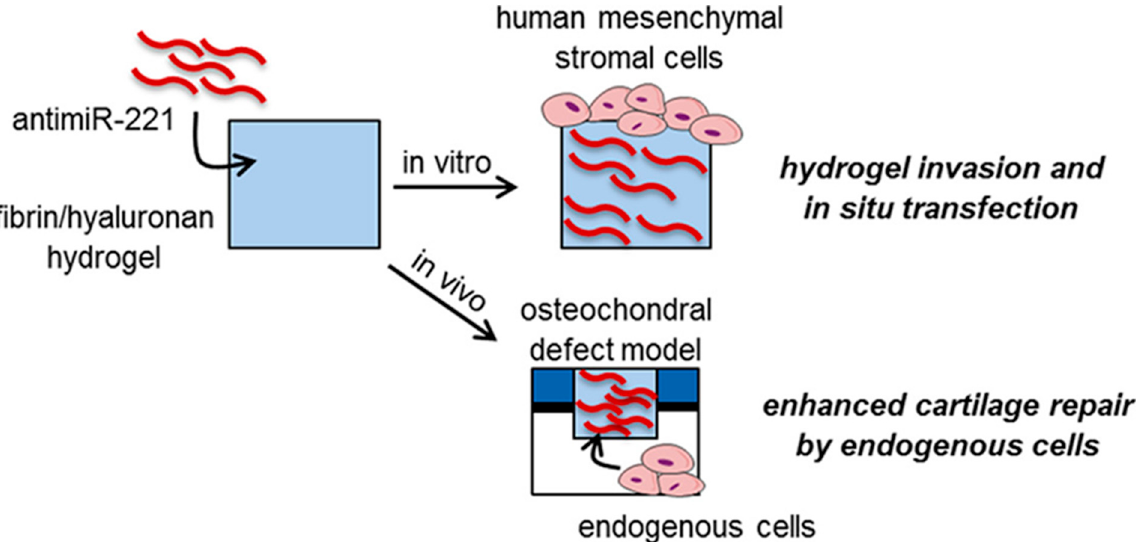
Figure 5. Lolli et al. investigated a new strategy based on hydrogel-mediated delivery of a locked nucleic acid microRNA inhibitor targeting miR-221 (antimiR-221) to guide in situ cartilage repair by endogenous cells, Reprinted from Ref. [96].